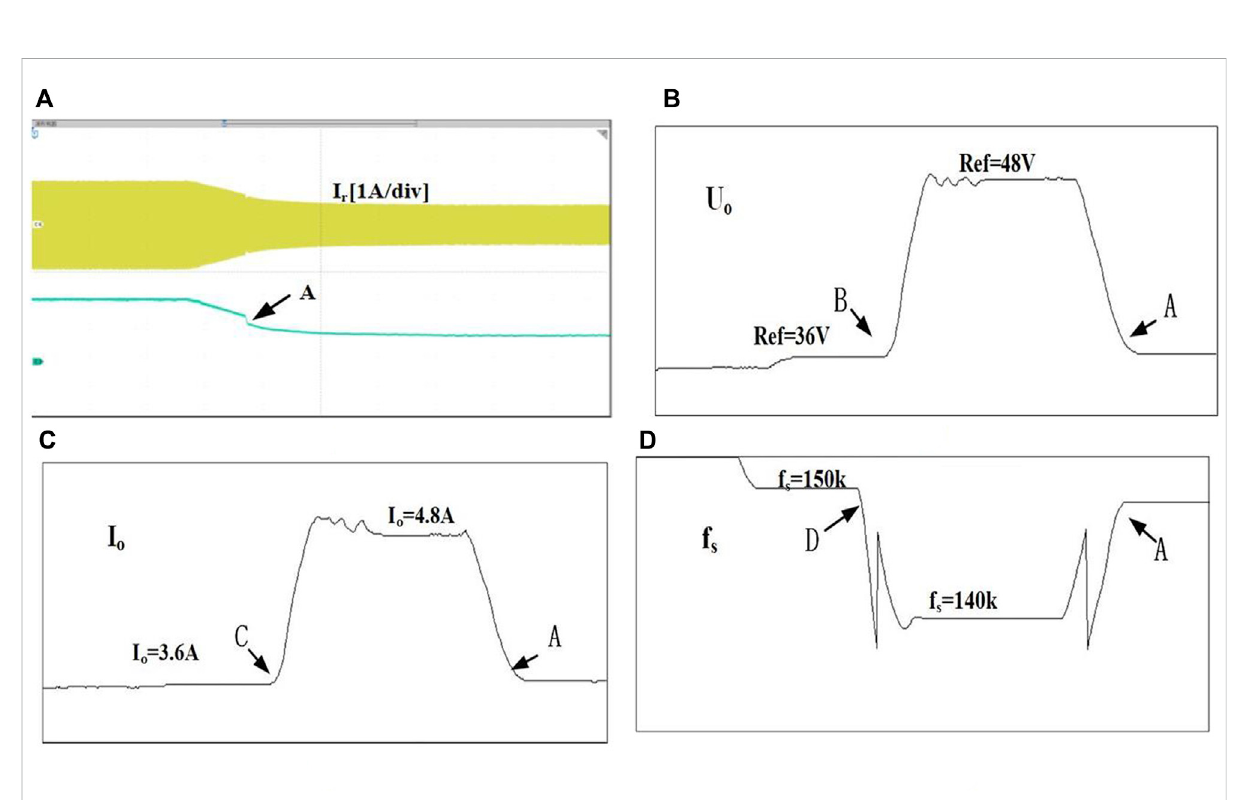
FIGURE 12 Reference change: (A) Graph of an oscilloscope. (B – D) The waveform monitored by the upper